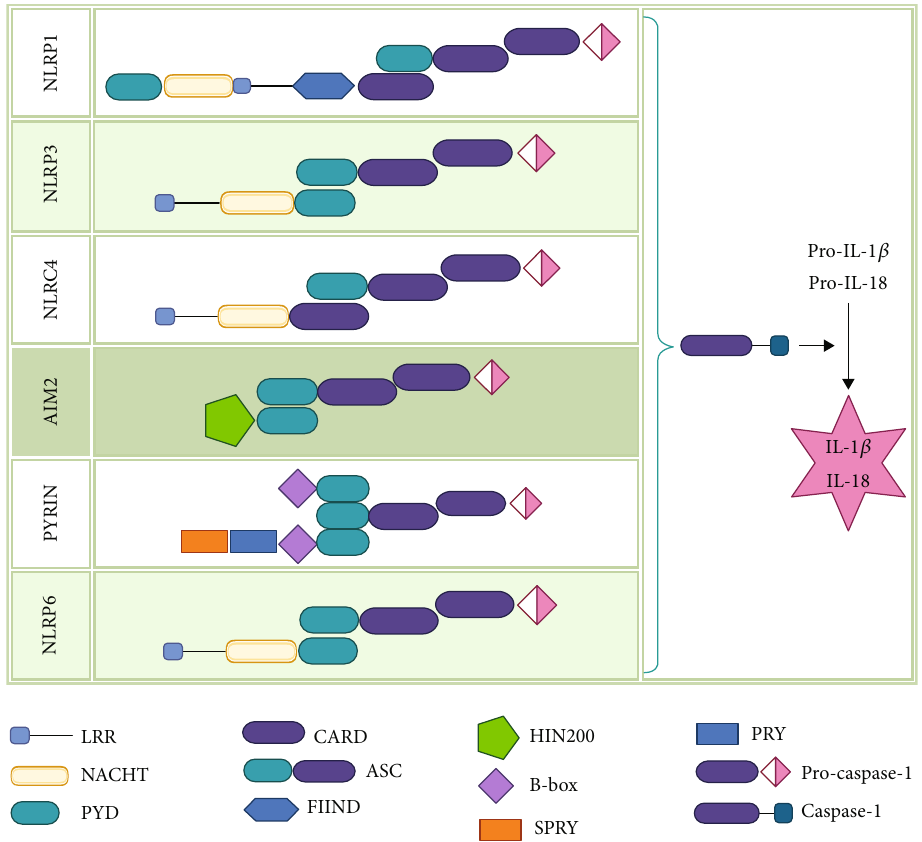
Figure 1: Particular structures of in fl ammasome complexes composed of three main components: sensor, adaptor, and e ff ector. The NLR proteins (Nlrp1, Nlrp3, Nlrp6, and Nlrc4) and HIN200 protein AIM2 mobilize the complexes in a stimulus-speci fi c manner. Activated receptors recruit the ASC adaptor protein, and the CARD domain from ASC protein structure is necessary for procaspase-1 recruitment and caspase-1 activation. Active caspase-1 induces secretion and maturation of pro-IL-1 β and pro-IL-18 into their active forms IL-1 β and IL-18 (image created in